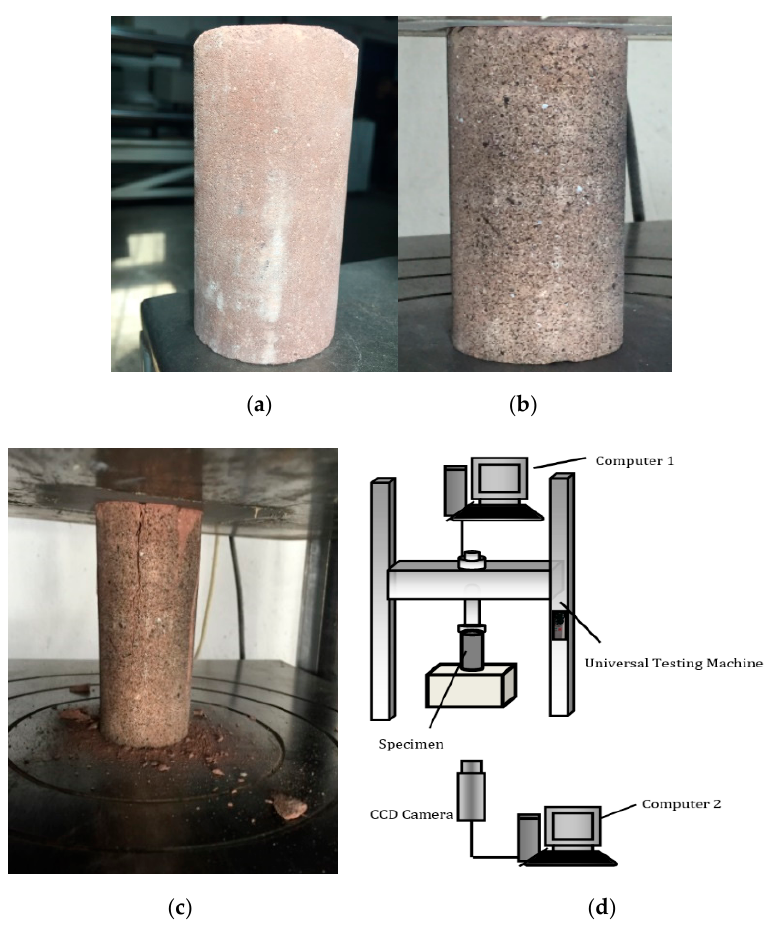
Figure 4. Experiment set-up: ( a ) specimen before painting; ( b ) specimen after painting; ( c ) specimen failure; ( d ) measuring system.